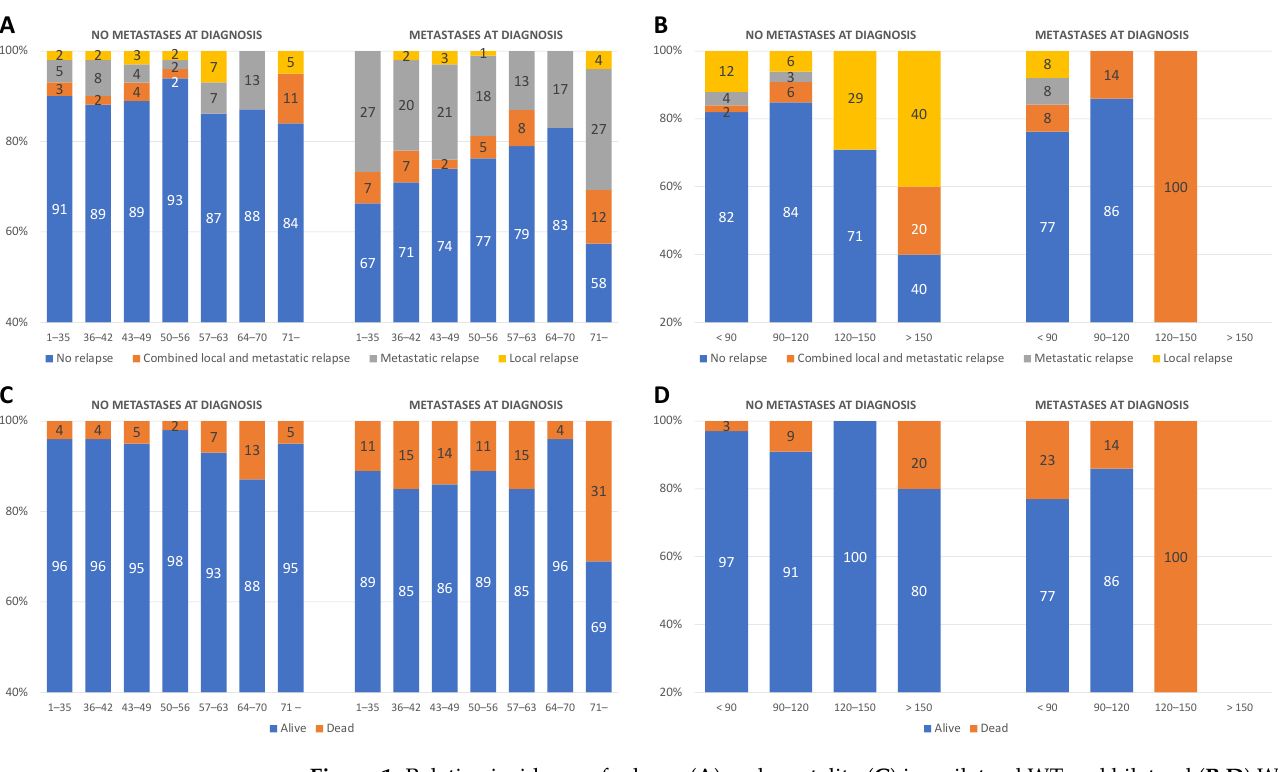
Figure 1. Relative incidence of relapse ( A ) and mortality ( C ) in unilateral WT and bilateral ( B , D ) WT without and with metastases at diagnosis and different preoperative treatment intervals.